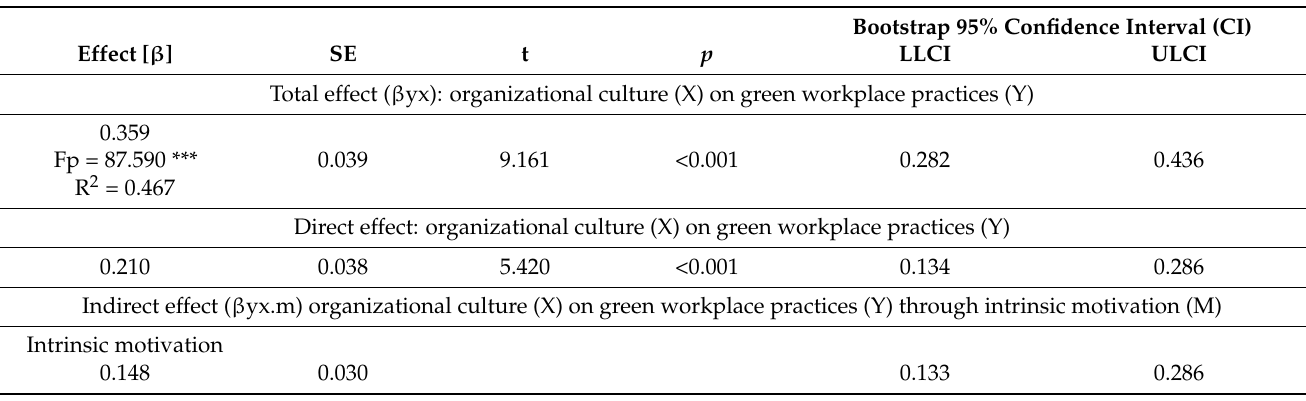
Table 4. Total, direct, and indirect links between organizational culture and green workplace practices through intrinsic motivation.